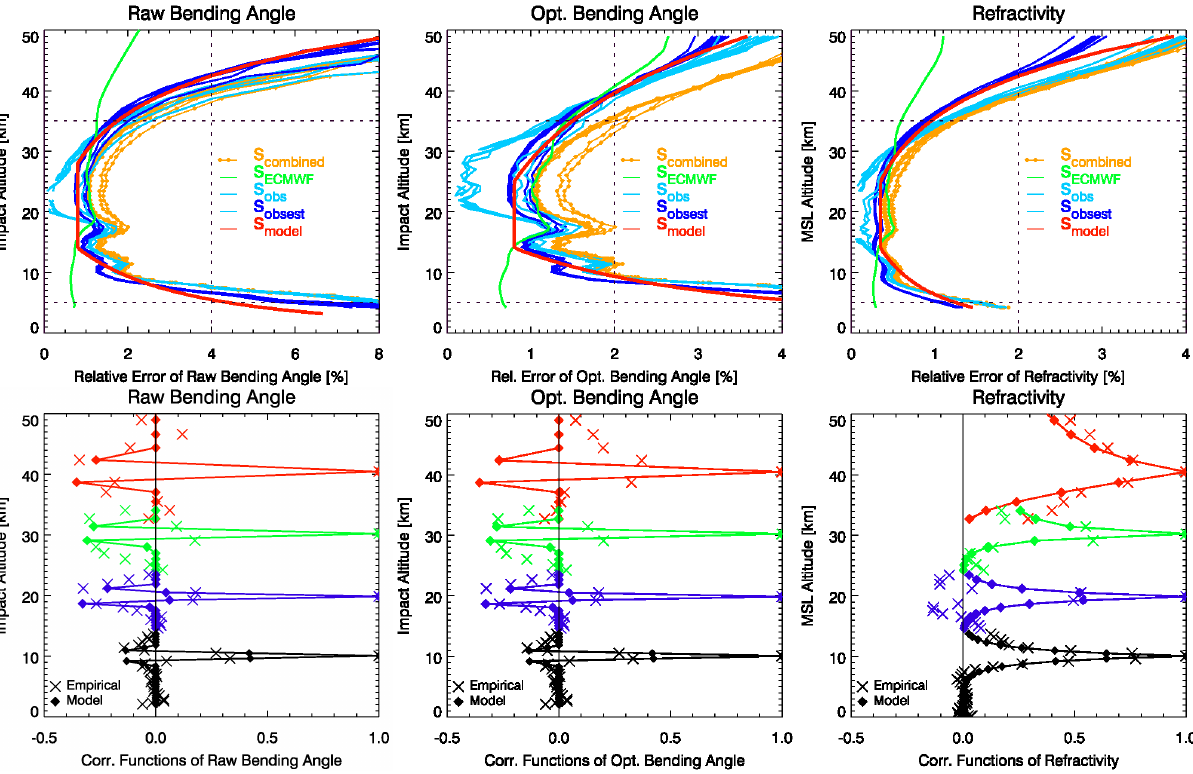
Fig. 7. UCAR global error estimates (top panels) and error correlation functions (bottom panels) in July 2008 for raw and optimized bending angles as well as for refractivity up to 50km. Empirical (x-symbols) and modeled (connected diamonds) correlation functions are shown based on GRACE-A data for four representative altitude levels from 10km to